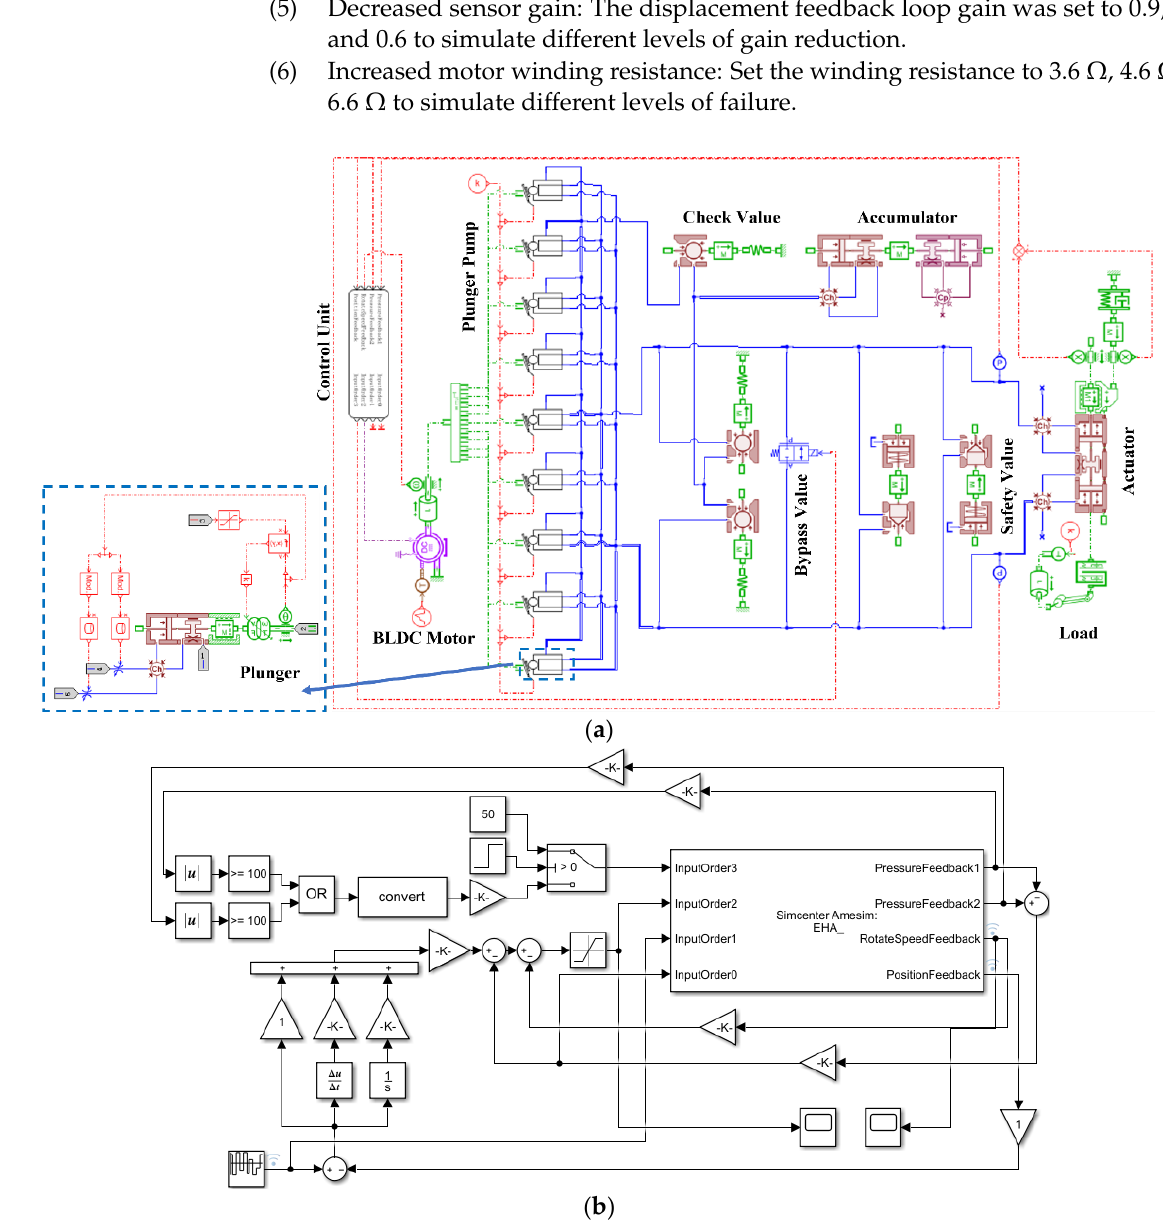
Figure 10. Physical simulation model of EHA-FPVS: ( a ) Model of hydraulic circuit; ( b ) Model of control unit.